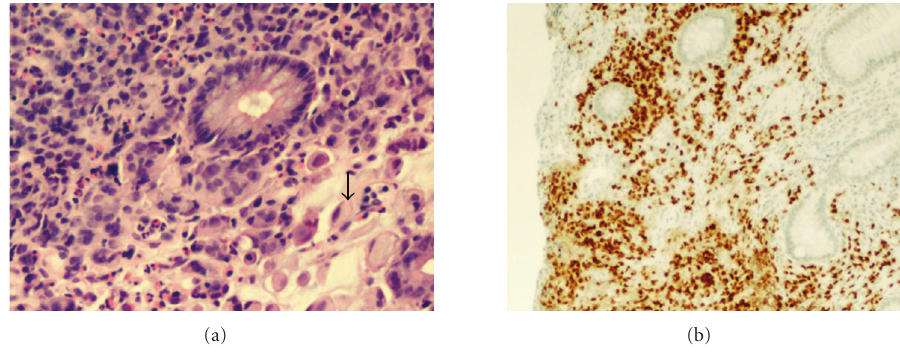
Figure 2: (a) Histopathology of biopsies taken from gastric lesions showing infiltrating adenocarcinoma with signet ring cell morphology (Arrow). (b) Immunohistochemistry of (a) showing positive ER.